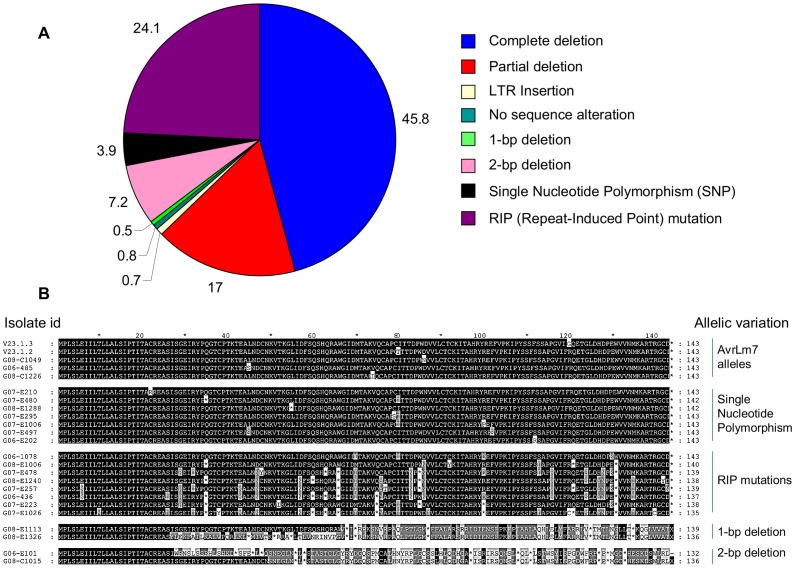
Main mutational events identified in the avrLm7 alleles and consequences for the protein produced.
A. Percentages of the main mutational events in the collection of 769 virulent avrLm7 isolates analysed (excluding nine isolates for which the mutation events could not be characterized). All isolates were obtained from the experimental plot at Grignon between 2006 and 2008. B. GeneDoc-edited alignment of representative variants of the AvrLm4-7 protein. The AvrLm4-7 protein sequences deduced for three avirulent isolates with the AvrLm7 specificity, and 19 virulent avrLm7 isolates with different mutation events leading to virulence are shown and compared to those of the two reference isolates v23.1.3 and v23.1.2. The intensity of shading reflects the intensity of sequence conservation. Stop codons are indicated as stars.